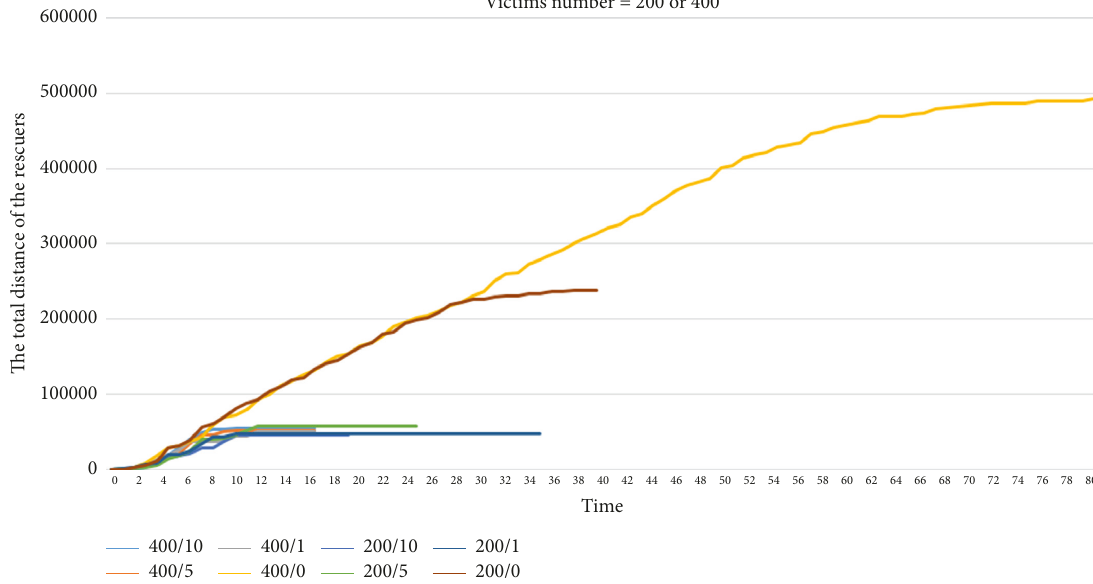
Figure 16: The total distance of all the rescuers over